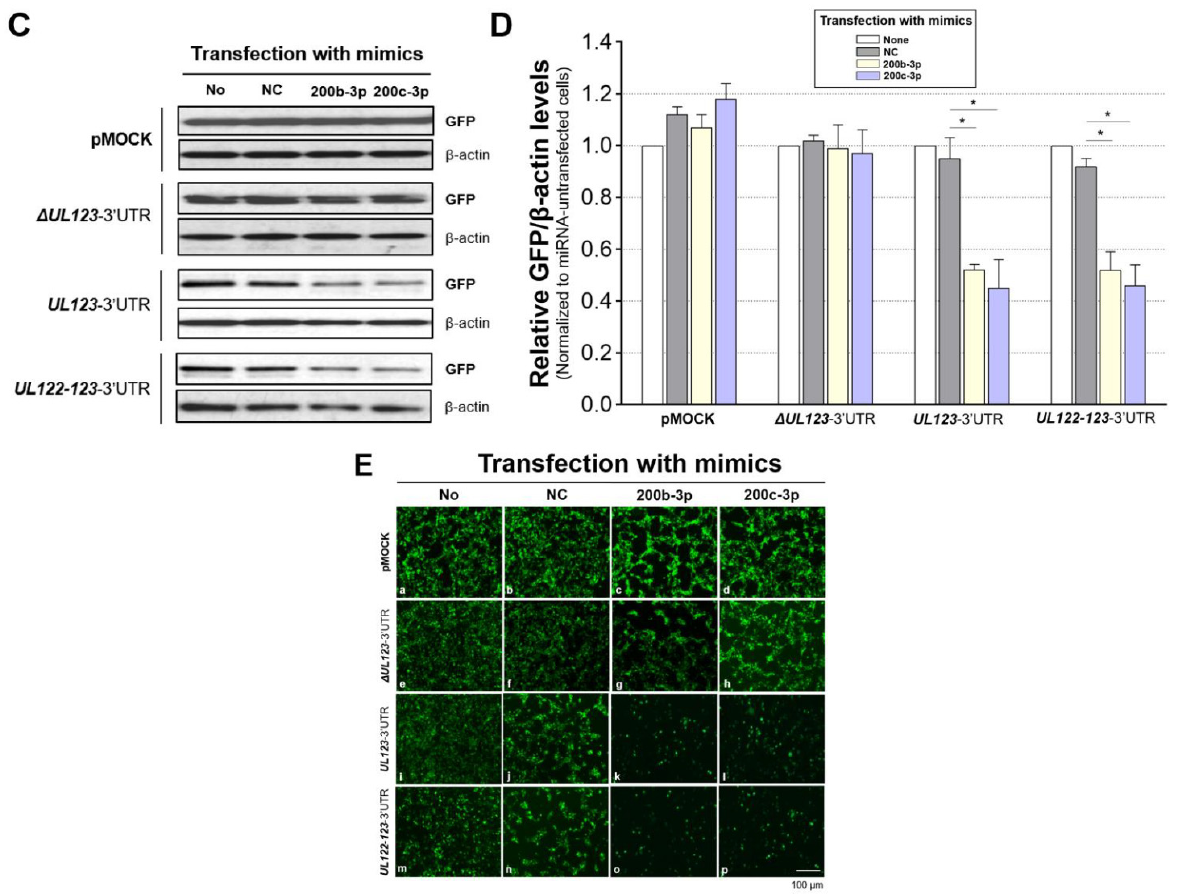
Figure 2. Binding capacity of miR ‐ 200b ‐ 3p and miR ‐ 200c ‐ 3p to the 3 ′‐ UTR of UL123 in cells stably expressing transfected GFP. We transiently transfected pMOCK, Δ UL123 ‐ , UL123 ‐ , and UL122 ‐ 123 ‐ 3 ′‐ UTR ‐ EGFP U373MG cells (1 × 10 6 /well; 6 ‐ well plates) that stably expressed transfected GFP, with miR ‐ 200b ‐ 3p or miR ‐ 200c ‐ 3p mimics or NC mimic (300 ng each) for 2 days. Positive control was pMOCK, which indicated that U373MG cells were stably transfected with empty pEGFP ‐ N1. ( A ) Percentage of GFP ‐ positive cells quantified using flow cytometry. Graphs of GFP ‐ positive cells were created using the FlowJo TM software. ( B ) Percentage of GFP ‐ positive cells upon transfection with each miR/NC. ( C , E ) Expression of GFP in four EGFP plasmid groups evaluated by immunoblotting and visualized using fluorescence microscopy . ( D ) Relative GFP expression was calculated as GFP/ β‐ actin signal density in each miR ‐ transfected cell (measured using ImageJ) and was expressed as the fold of the value in mimic untransfected cells. All quantitative data represent triplicate experiments involving SCs transfected with miRNA mimics. Upper lines in box and error bars indicate means and SEM, respectively. * p < 0.001 vs. NC mimic ‐ transfected cells.